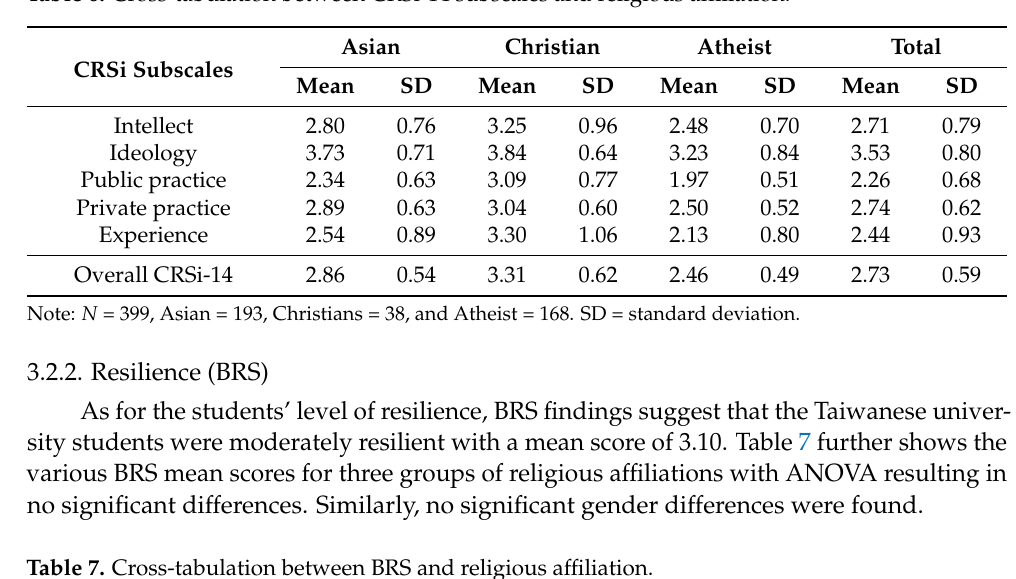
Table 7. Cross-tabulation between BRS and religious affiliation.